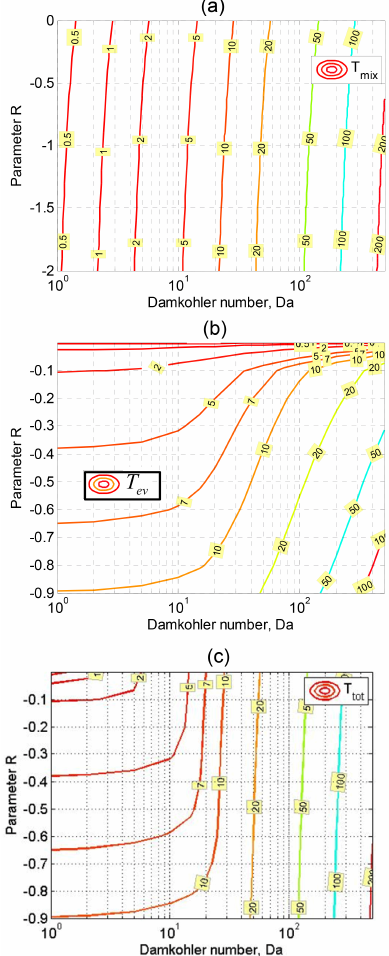
Figure 15. Contours of normalized mixing duration times on Da − R plane. (a) Mixing time T mix , (b) evaporation time T ev , and (c) the total duration mixing time T tot